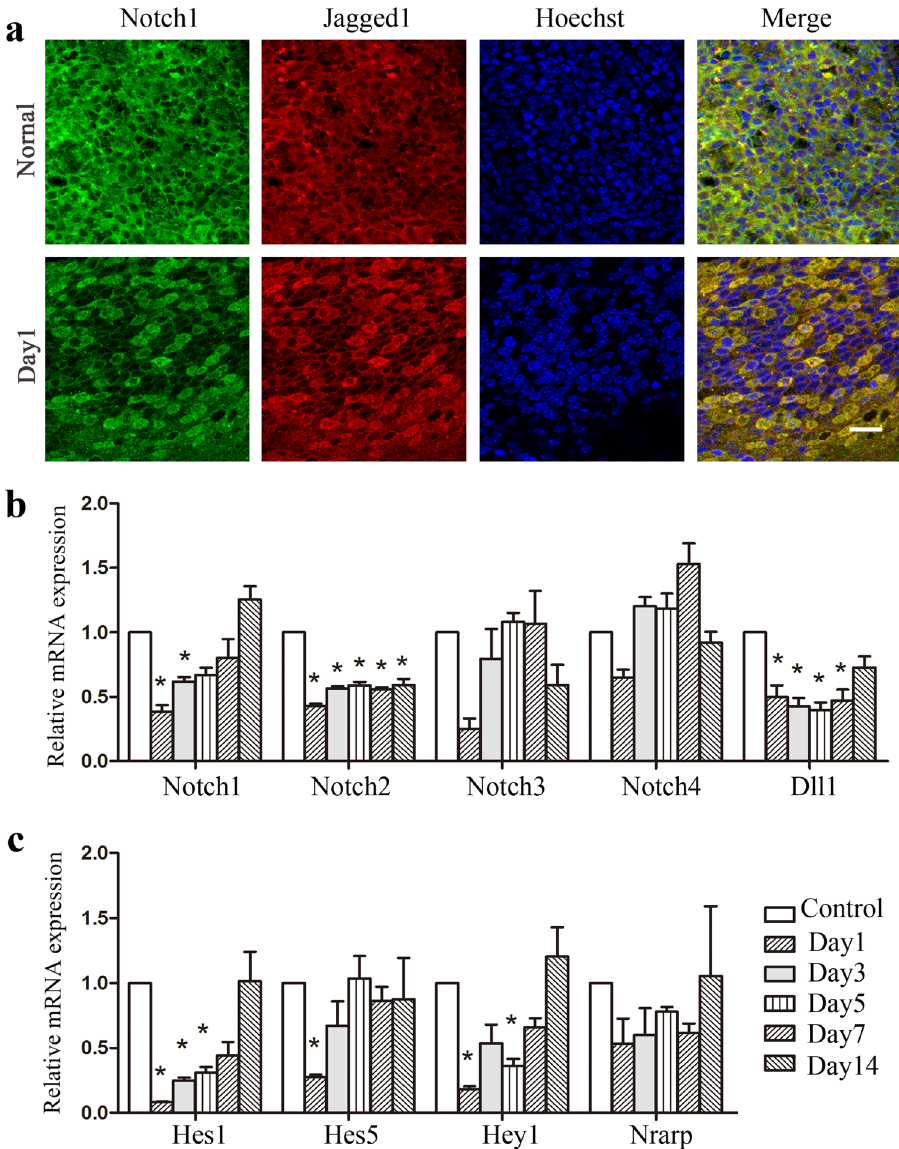
Figure 5. Notch signalling downregulated during AOM. Notch1 and Jagged1 were detected by immunolocalisation. Gene expression of Notch receptors and ligands (Notch1, Notch2, Notch3, Notch4, and Dll1) and Notch signal target genes (Hes1, Hes5, Hey1, and NRARP) was analysed in the mouse middle ear epithelium before and after injection with Streptococcus pneumoniae (n = 2, repeated 3 times). ( a ) Immunostaining of Notch1 and Jagged1 in mouse middle ear epithelium. Faded staining of Notch1 and Jagged1 can be seen at day 1. Scale bar, 20 µ m. ( b ) Gene expression of Notch receptors and ligands (Notch1, Notch2, Notch3, Notch4, and Dll1) in mouse AOM. Notch1 mRNA levels were significantly lower on days 1 and 3. Notch2 mRNA levels were greatly decreased through days 1, 3, 5, 7, and 14 in AOM. The Dll1 mRNA levels showed the same trend as Notch2. ( c ) Expression of Notch signal target genes (Hes1, Hes5, Hey1, and NRARP) in mouse AOM. Hes1, Hes5, and Hey1 mRNA expression was significantly decreased at day 1. On days 1, 3, and 5, Hes1 transcript levels were significantly lower than in